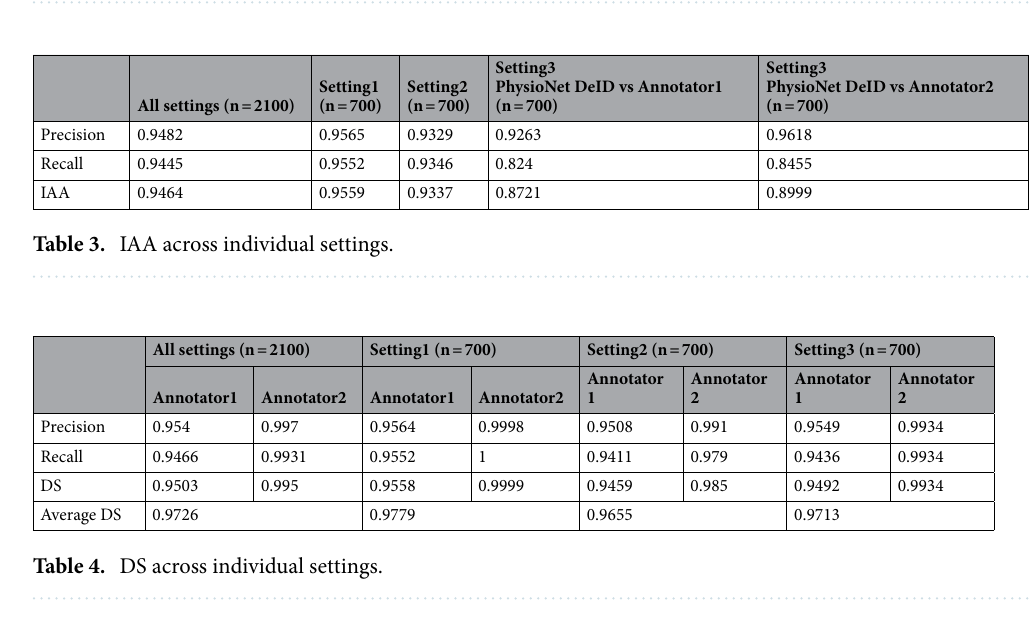
Table 2. Time spent under each annotation setting.